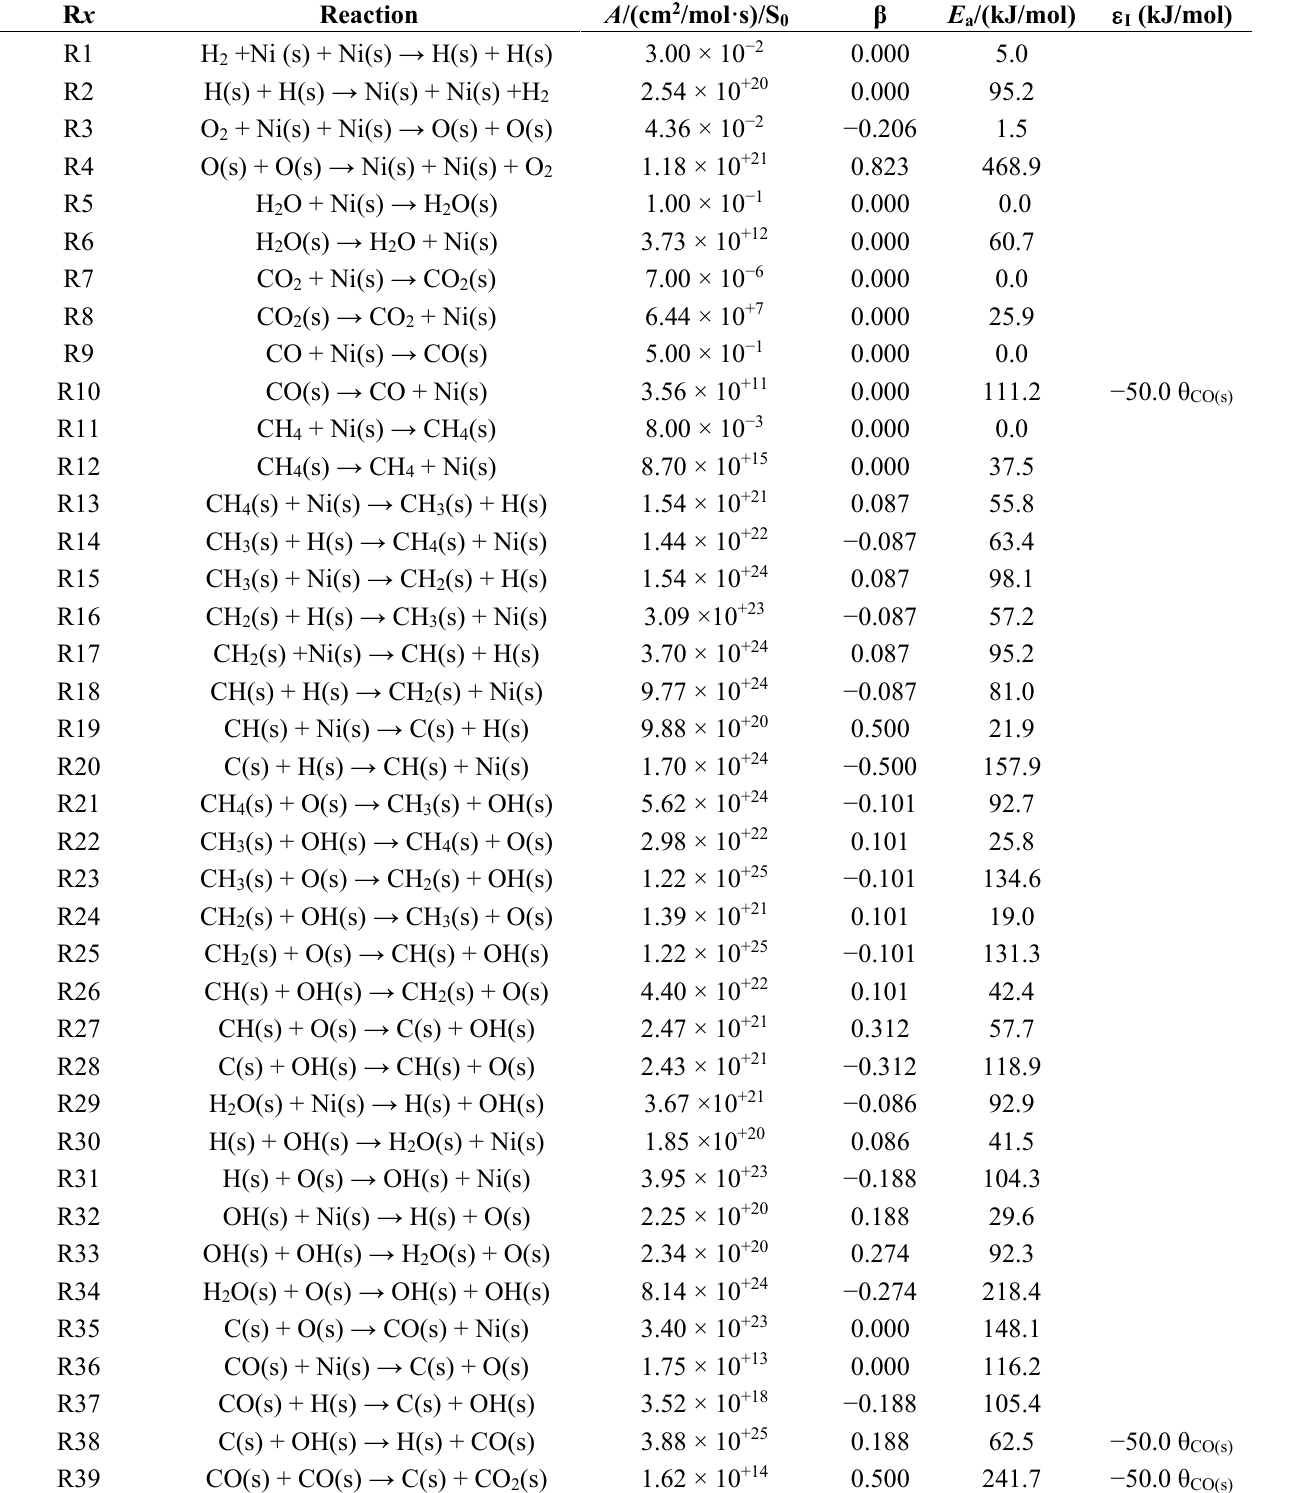
Table 3. Surface reaction mechanism for methane oxidation and reforming over Ni-based